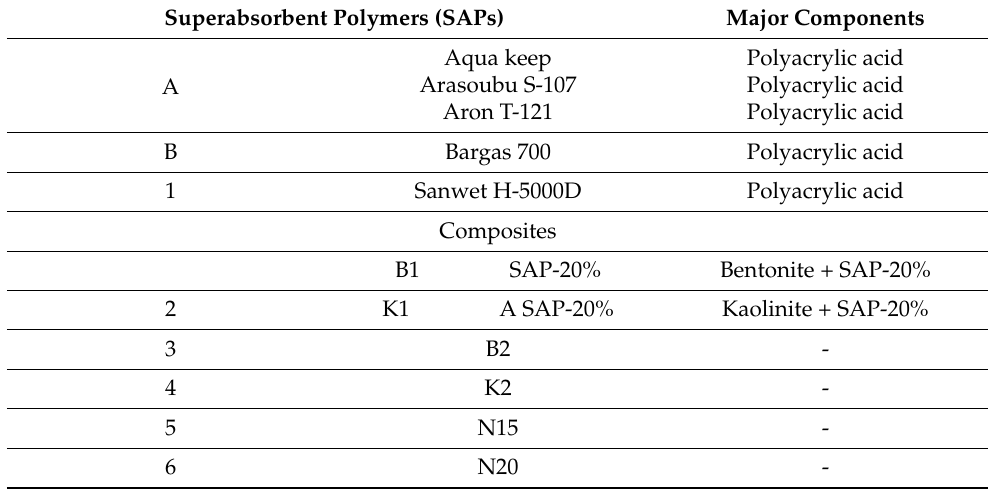
Table 2. List of major components of superabsorbent polymers (SAPs) and composites. Superabsorbent Polymers (SAPs)